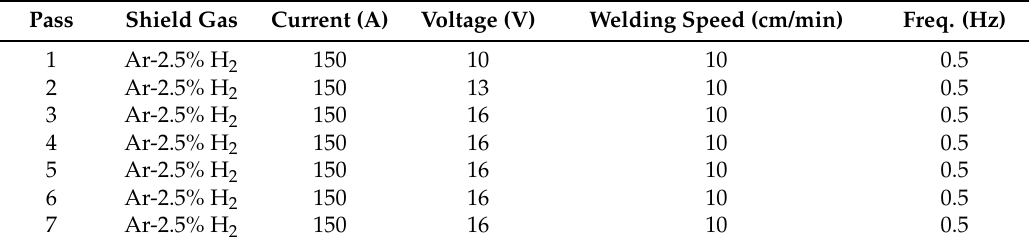
Table 3. Multi-pass dissimilar material welding conditions between Alloy 617 and 12Cr steel.